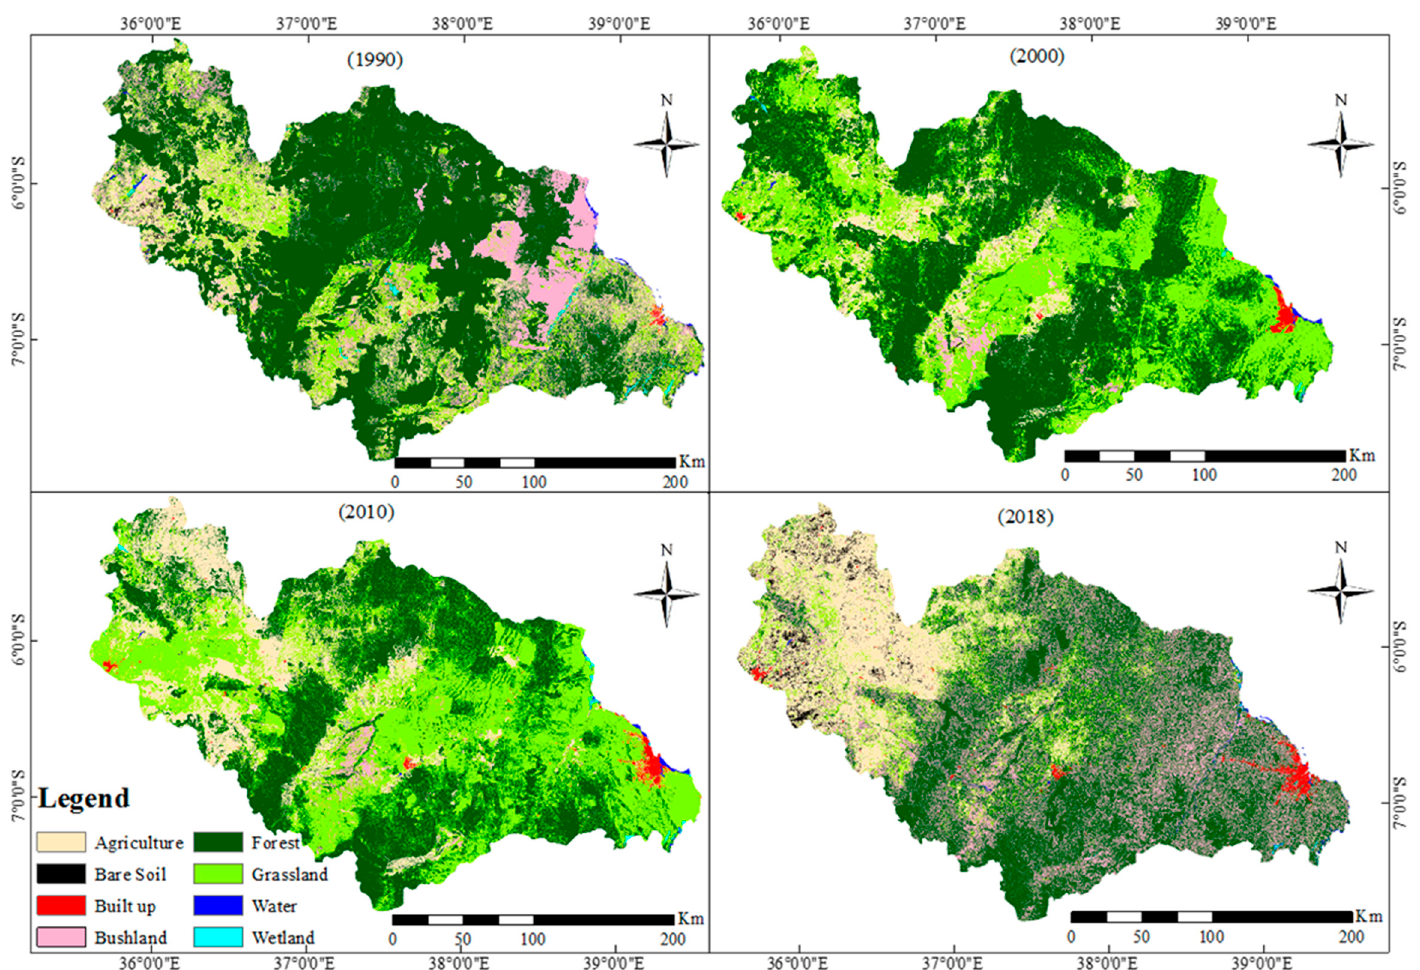
Figure 6. The classified LULC types of the Wami–Ruvu Basin for 1990, 2000, 2010, and 2018.